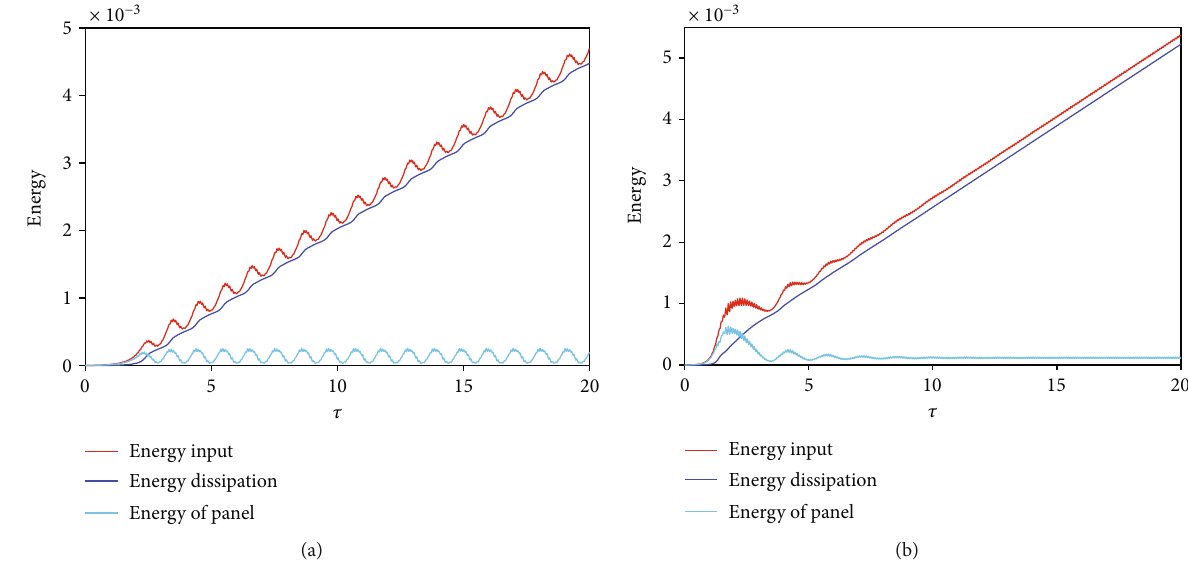
Figure 10: Time history of energy with an NES: (a) λ = 355 ; (b) λ = 368 .